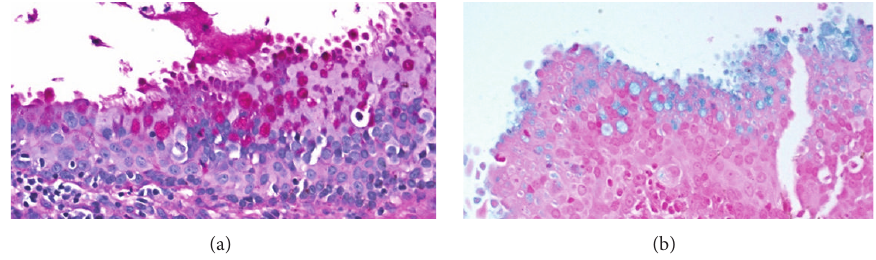
Figure 4: The mucin vacuoles are positive for the periodic acid-Schiff (PAS) and alcian blue stains. (a) Positivity to PAS. (b) Positivity to alcian blue